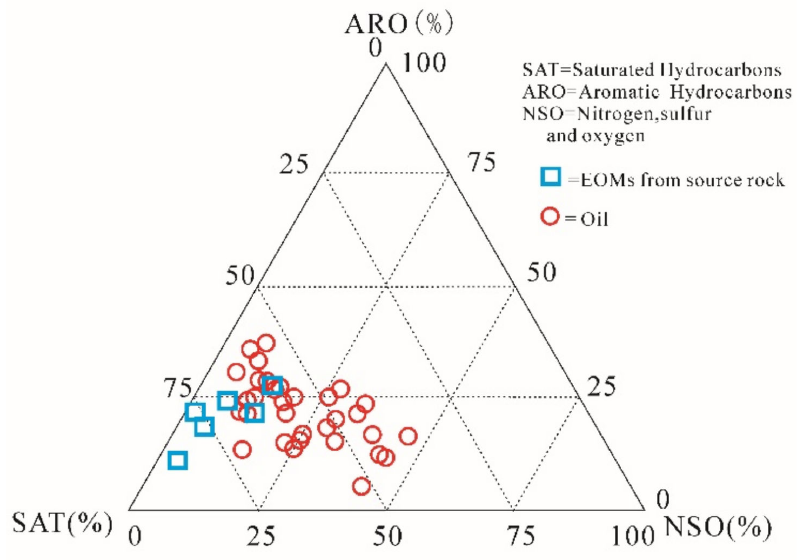
Figure 5. Ternary diagram of the extracted samples of the Hengtongshan Formation in the Tonghua Basin showing the relative proportions of saturated, aromatic and NSO